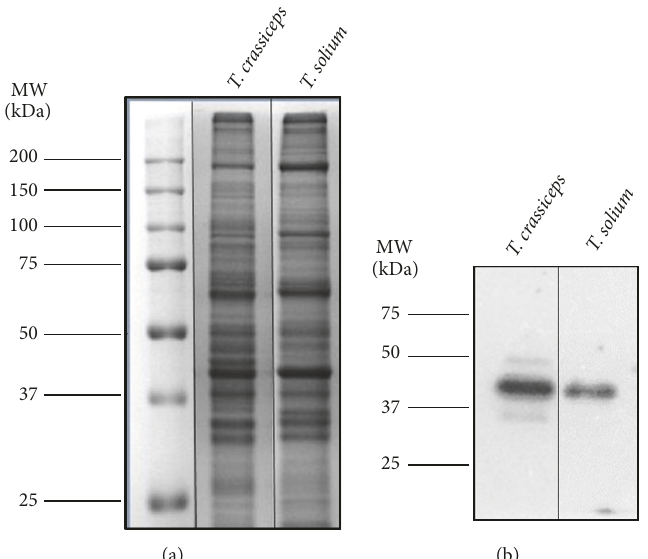
Figure 6: Electrophoretic and immunochemical analysis of taeniid septin-like proteins. (a) SDS-PAGE of the T. crassiceps and T. solium protein extracts stained with Coomassie blue. Molecular weight (MW) markers are indicated in the first lane. (b) Immunorecognition with the anti- SEPT4 Tsm antibody in T. crassiceps and T. solium protein extracts. Evaluation was performed by chemiluminescence following western